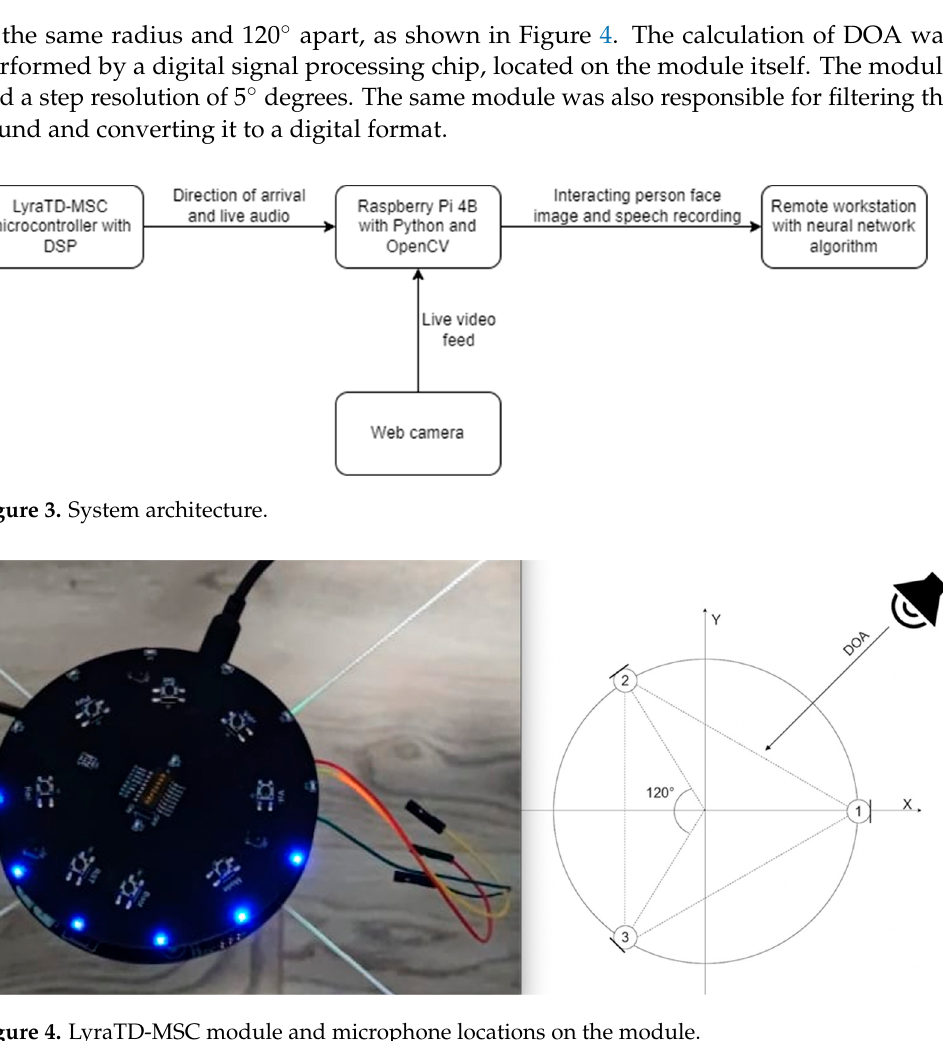
Figure 4. LyraTD-MSC module and microphone locations on the module.